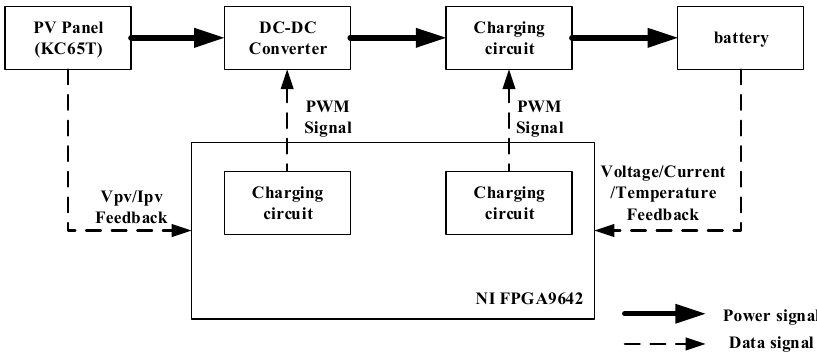
Figure 1. Schematic diagram of the solar power system circuit.